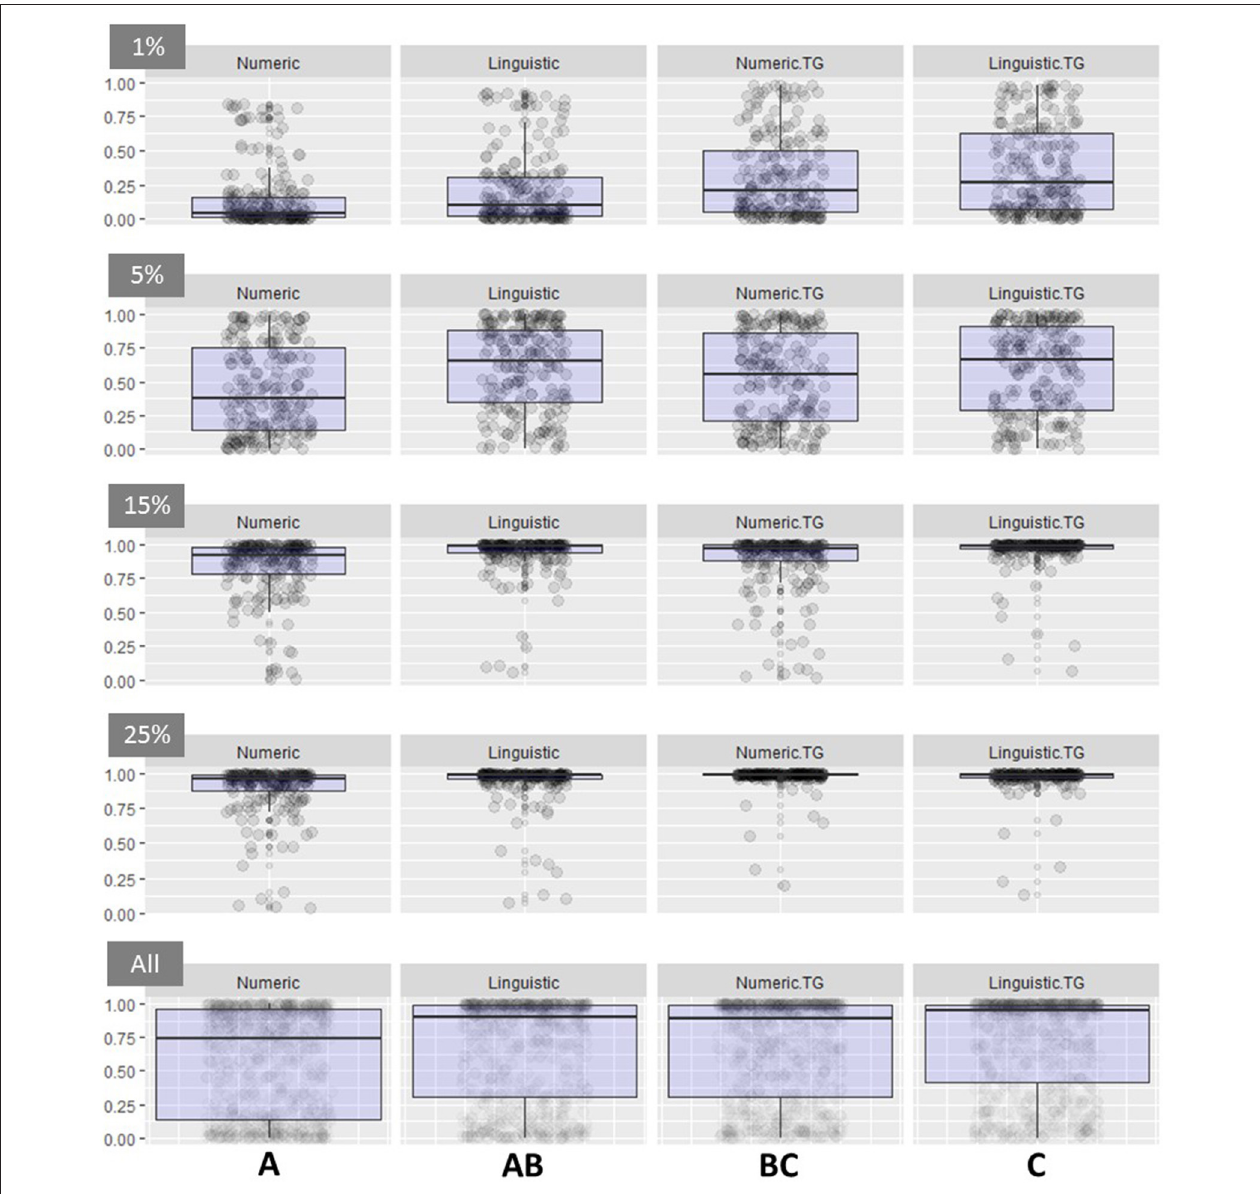
FIGURE 2 | Box plot depicting results from the Mixed Effect Logistic Regression model for each of four levels of Infection Risk and the combination of all infection risk categories (Rows: 1, 5, 15, and 25%, All infection risk categories combined). The y-axis reports the probability of compliance with the biosecurity practice. Columns depict treatments (Left to Right: Numeric, Linguistic, Numeric Threat Gauge, and the Linguistic Threat Gauge. Significance between treatment categories is noted by bold letters on the bottom of the